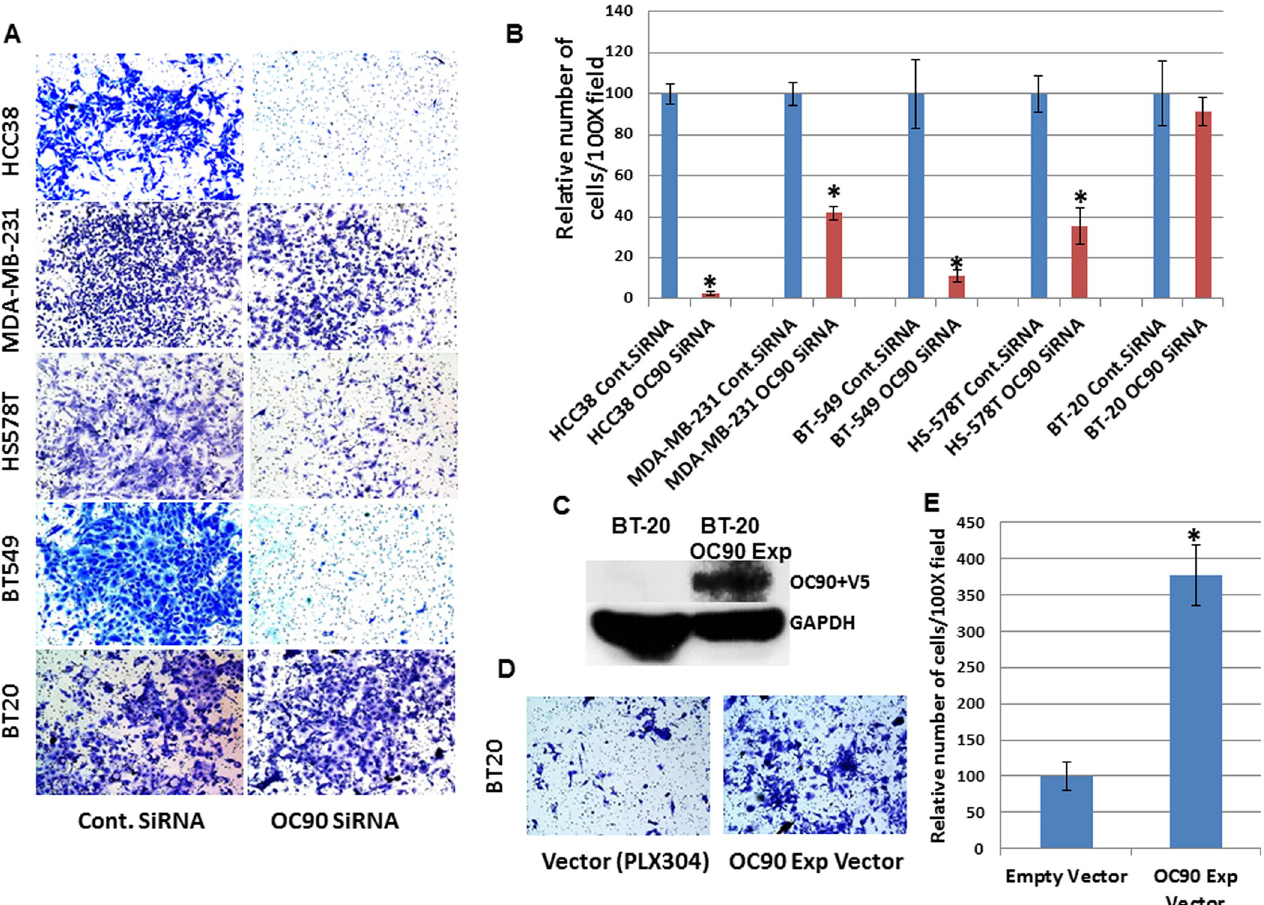
Fig 5. Modulating OC90 expression in TNBC cell lines affects invasion into Matrigel. A) Photographs of slides with mounted Boyden chamber membranes were counted under the high power field (100X) of the microscope following Control siRNA and OC90-siRNA treatment. B) Bar graph shows the relative number of invading cells from (A) after OC90 knockdown compared to control siRNA treatment ( � p < 0.05) C). Western blot showing V5 tagged OC90 expression in BT-20 cells after transfection with OC90 expression vector. D) BT-20 cell line after empty vector and OC90 expression vector transfection. E) Bar diagram shows relative number of invaded cells after empty vector and OC90 expression vector transfection in BT-20 cell line ( � p < .05).